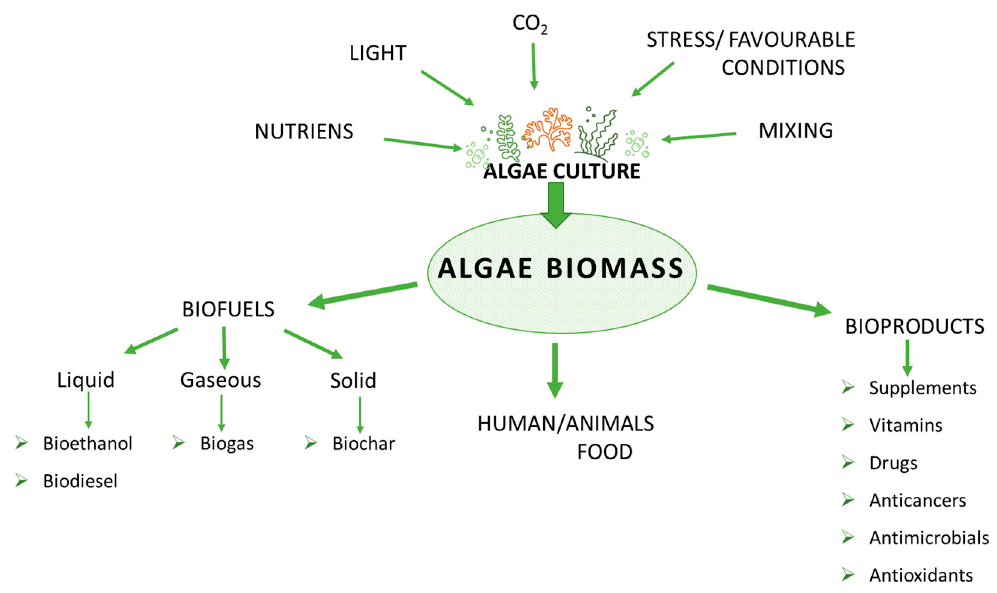
Figure 1. Physical and chemical conditions influencing algal biomass production and possibilities of the use of an obtained algal biomass in different industry branches.